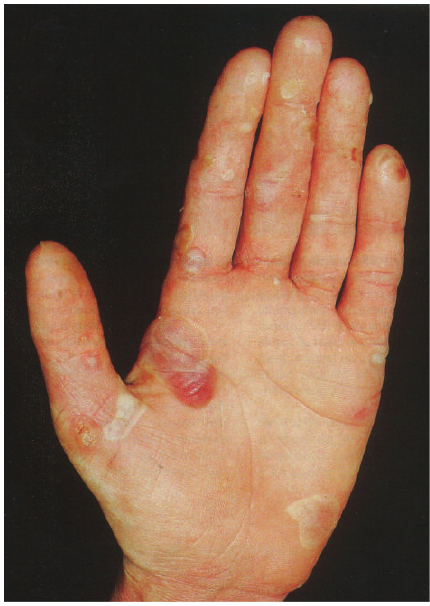
Figure 20: Epidermolysis bullosa [9, page